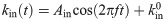
Frequency responses of the CCC model.(A) Changes in the concentration of the active carrier vs. cyclic changes in kin(t). kin(t) is given as kin(t)=Aincos(2πft)+kin0, where Ain and f represent the amplitude and the frequency of kin(t), respectively. Here, kin0 equals 1, which is higher than kinth, and can be calculated in the case of kleak = 0, while we set kleak = 0.001. We calculated the difference between the maximum and minimum values of [c] following the cyclic changes of kin(t). We observed a similar response for [c*], m1, and m2. Different colors indicate the responses obtained for different input amplitudes. Magenta, Ain = 0.1; orange, Ain = 0.4; green, Ain = 0.7; blue, Ain = 1.0. (B) Changes in the concentration of the active carrier with various Ain and f plotted as a color map. The red dotted line indicates the estimated cut-off frequency calculated from Eq (6).